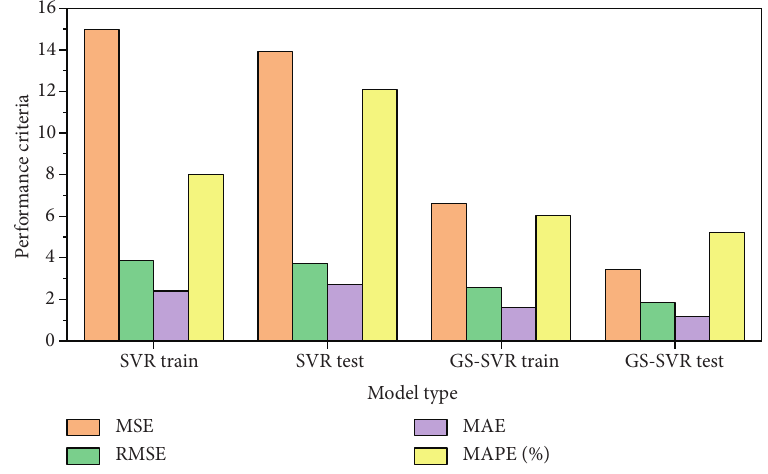
Figure 8: Performance criteria of the models. Table 2: Deterministic values of configuration